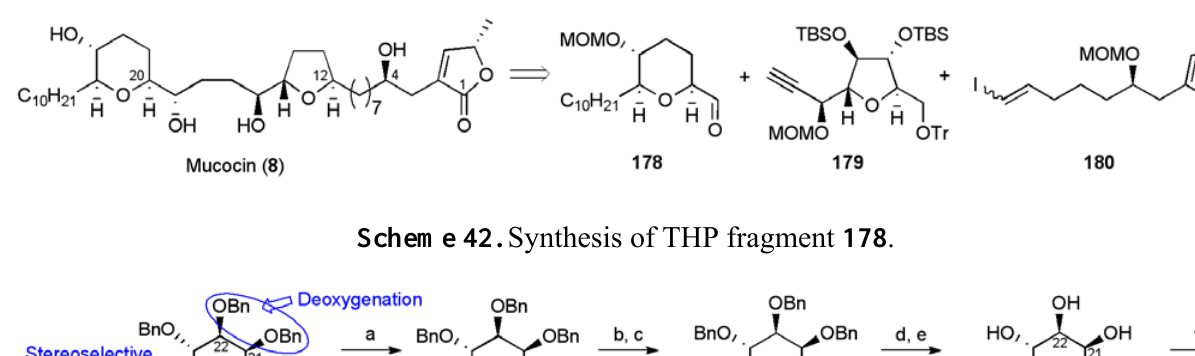
Figure 23. Synthesis of mucocin ( 8 ) from carbohydrate starting materials (2002).